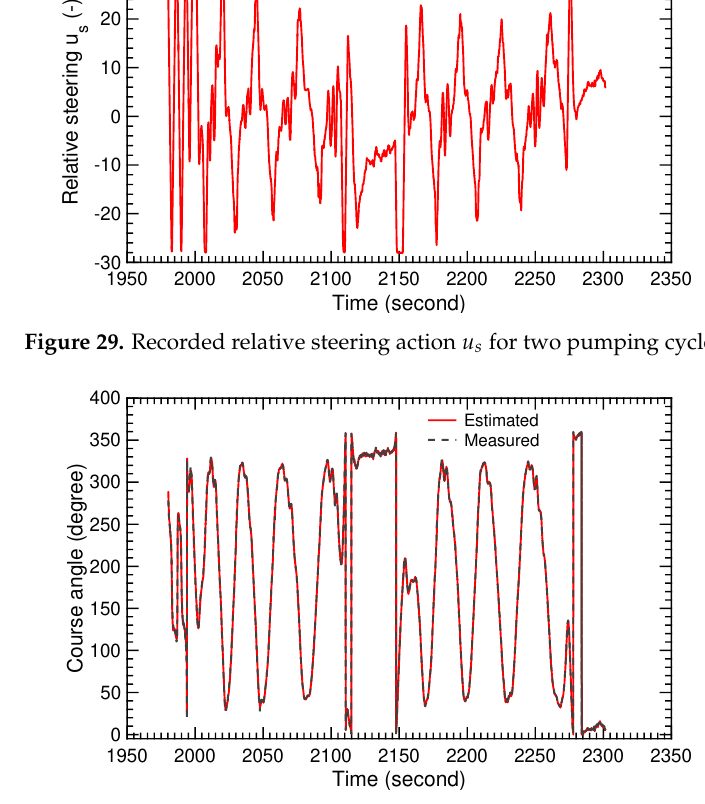
Figure 30. Measured and estimated course angle for two pumping cycles.